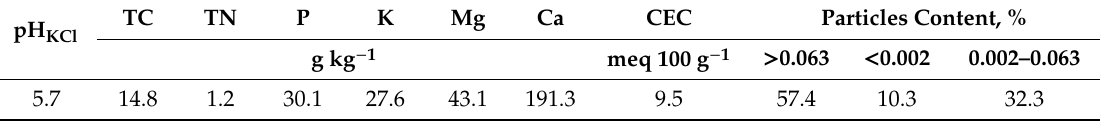
Table 1. Initial physicochemical properties of the soil used in the incubation experiment.